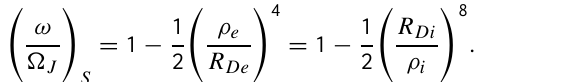
of boundary condition in this case (Cowley et al., 2003). The dashed lines in Fig. 2 show some approximate forms, with the tick marks indicating their regimes of validity. The long- dashed lines show the small- ρ e (‘ S ’) approximation given by Eq. (8), which in normalised form